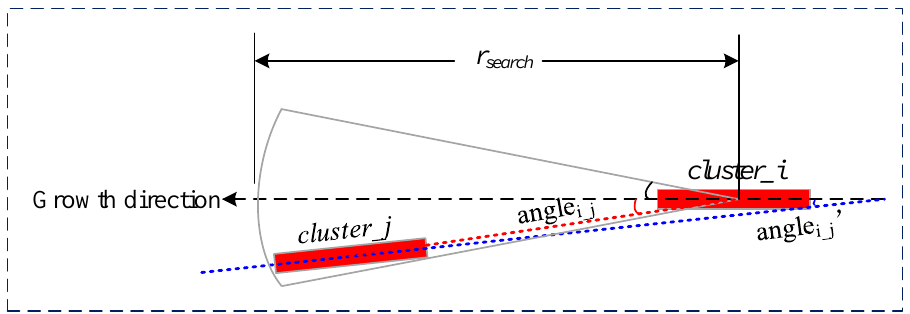
Figure 9. Diagrammatic sketch of the determination of the growth direction.